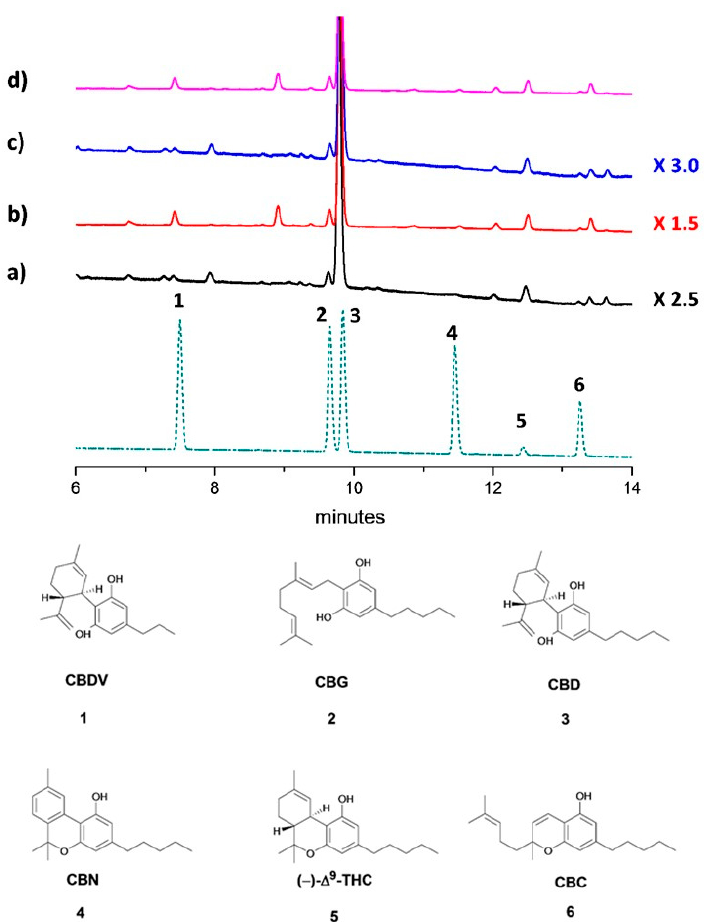
Figure 1. UHPLC chromatograms of inflorescences ethanol extracts from: ( a ) Uso-31 cultivar; ( b ) Felina 32 cultivar; ( c ) Ferimon cultivar; ( d ) Fedora 17 cultivar. For peaks identification, the chromatogram of a six-component cannabinoids standard ( 1–6 ) mixture has been carried out (bottom). The biogenic amines (BAs) presence in the aqueous extracts was verified by means of HPLC-FD (Figure 2). Five out of seven BAs monitored in the samples were present. Putrescine (PUT), tyramine (TYM), spermidine (SPD) and spermine (SPM) were always detected, whereas cadaverine (CAD) was found only in the September samples (Table 6). β -Phenylethylamine ( β -PEA) and histamine (HIS) were not detected in the analyzed